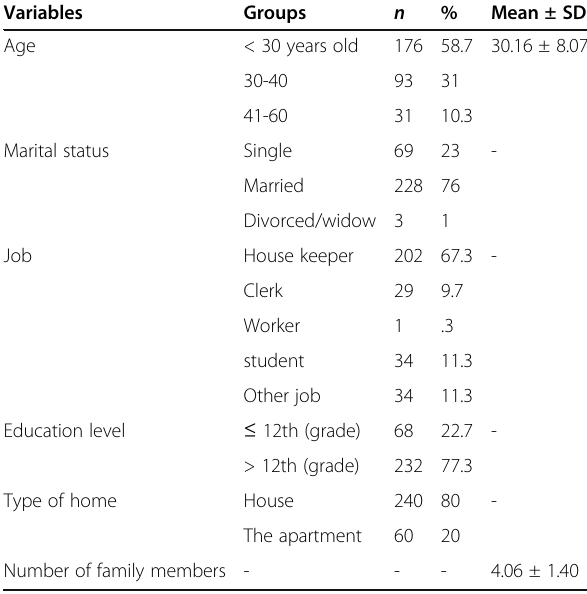
Table 2 Demographic characteristics of participant in exploratory/confirmatory factor analysis ( n = 300)